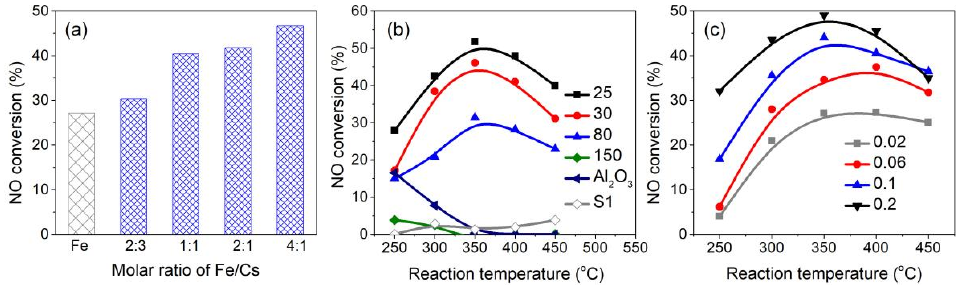
Figure 5. NO conversion of Fe-based HZSM-5 catalyst: ( a ) Fe/Cs molar ratio; ( b ) Si/Al molar ratio of HZSM-5; ( c ) exchange-solution concentration of Fe nitrate. NO = 1000 ppm, SO 2 = 500 ppm, O 2 = 10 vol.% with N 2 as balance gas, GHSV = 15,000 h − 1 .